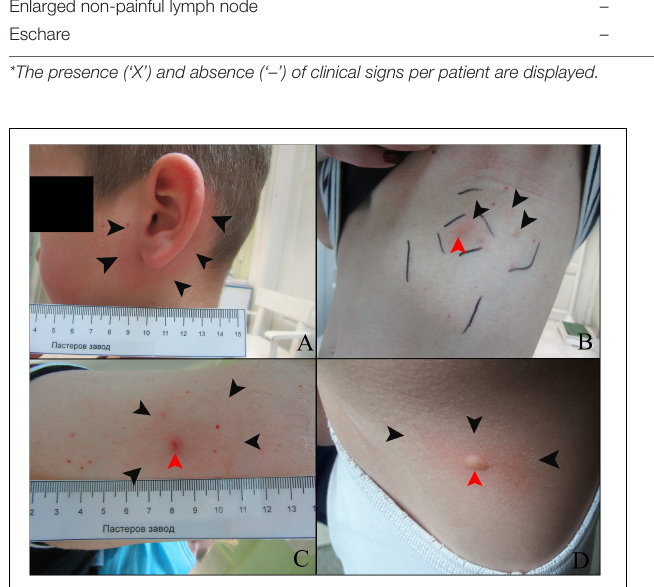
FIGURE 2 | Skin lesions in patients infested with ticks. (A) Patient 597/20; black arrows point to the erythema migrans. (B) Patient 225/20; non-specific condition as consequence of tick bite encircled with outer and inner squares. Black arrows point to a non-specific focal redness, while the red arrow points to the site of the latest tick infestation. (C) Patient 370/20; black arrows point to a non-specific mild red lesion, while the red arrow points to the site of the latest tick infestation. (D) Patient 412/20; black arrows point to a reactive red area surrounding urtica (pointed to by a red arrow) at the site of a previous